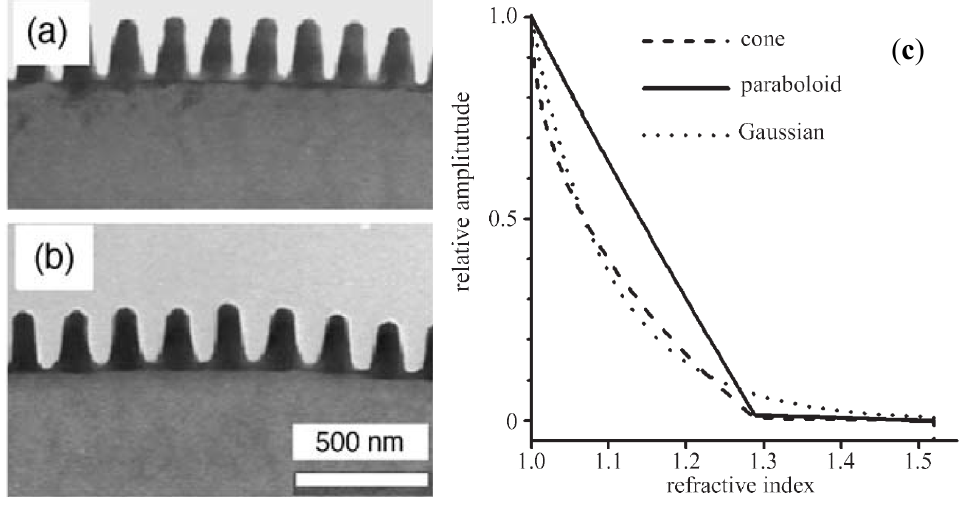
Figure 6. TEM images of moth eye nipple arrays ( a , b ) and ( c ) the effective index